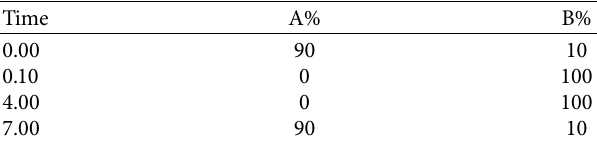
Table 1: Water alliance 2695 HPLC pump gradient timetable.